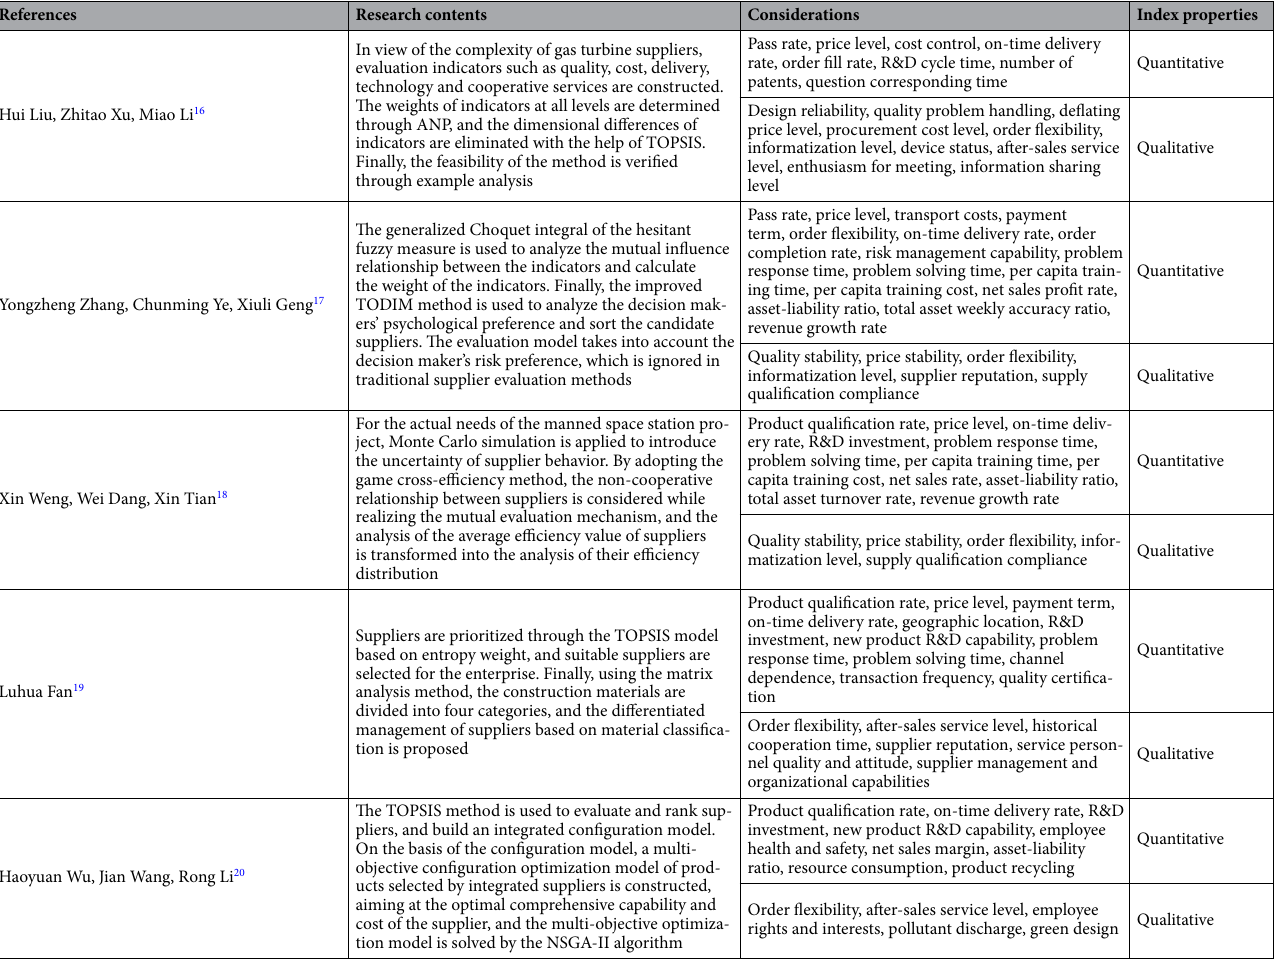
Table 1. Criteria involved in long term